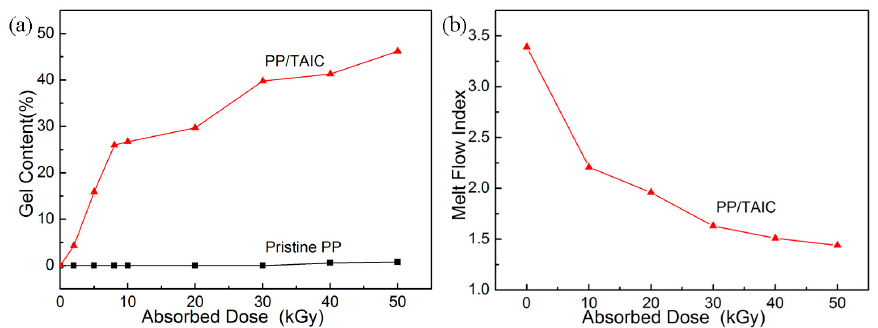
Figure 1. Effect of absorbed dose on the pristine PP and PP/TAIC (the amount of TAIC was 2 wt %) blends: ( a ) gel content and ( b ) melt flow index. Table 1. Melting point (T m ) and degree of crystallinity (X c ) of pristine polypropylene (PP) and PP with the addition of triallylisocyanurate (PP/TAIC) irradiated at different doses. Dose (kGy)